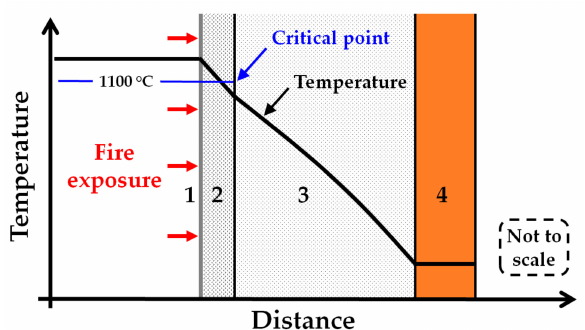
Figure 14. Sketch of fire exposure, weather protection cladding (1), the layer of heat-resistant insulation (2), thermal insulation (3) and the object to be protected from fire exposure (4). The critical point to be kept below is a temperature of 1100 ◦ C, which is marked on the